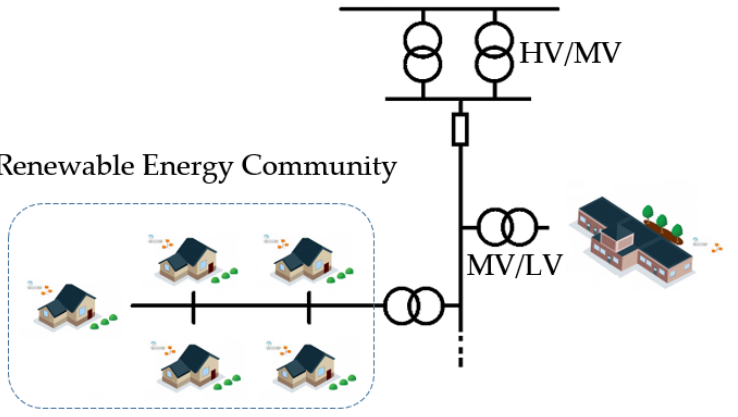
Figure 7. The renewable energy community under study.